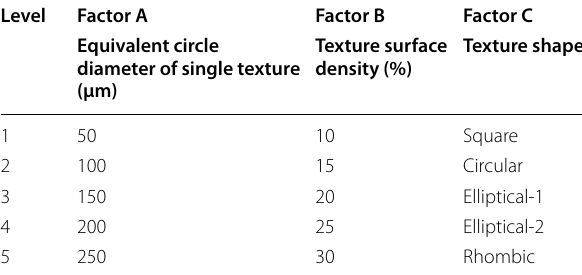
Table 2 Factors and levels of disassembly damage simulation experiment